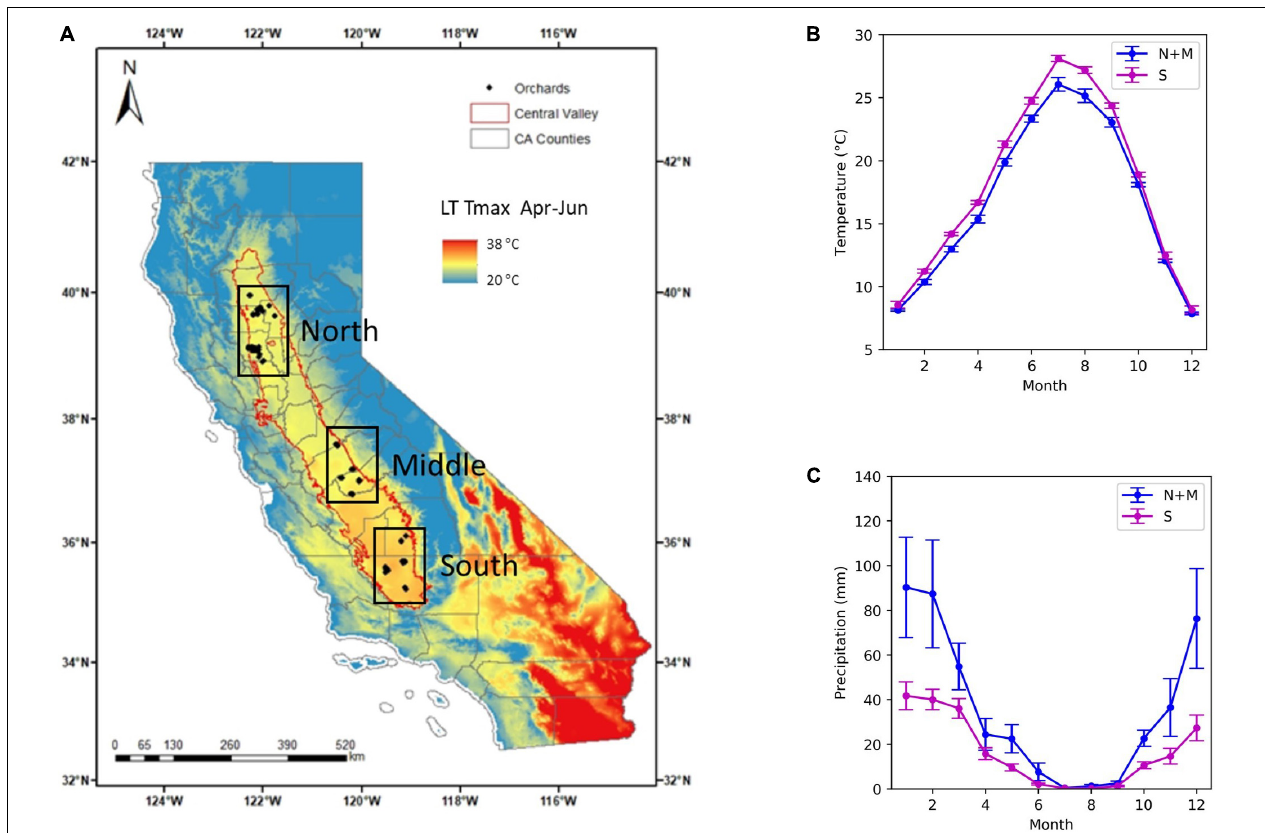
FIGURE 1 | Almond orchard study area in California’s Central Valley. (A) Historical yield records from growers were collected for a total of 185 almond orchards (diamond), located in three subregions: north, middle, and south (black boxes). The long-term mean maximum temperature (LT Tmax) during April–June from 1900 to 2009 is shown in the background. Also shown are (B) Mean monthly temperature and (C) monthly precipitation averaged over northern and central (blue) and southern subregions